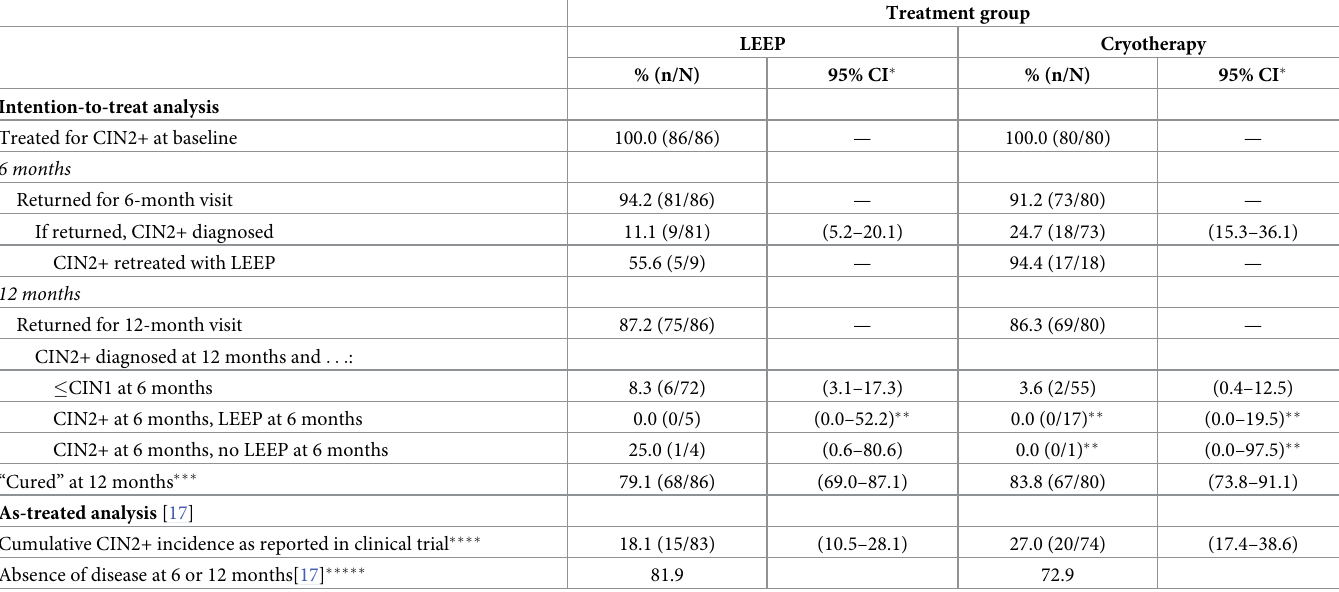
Table 1. Treatment outcomes at 6- and 12-months, intention-to-treat and as-treated [17] analyses (% (n/N)).